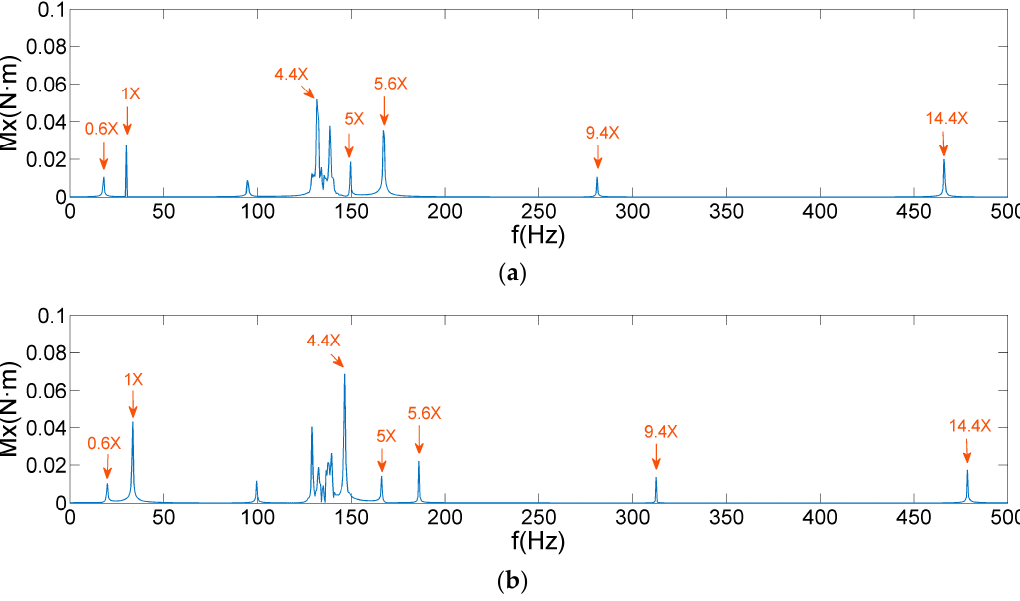
Figure 17. AIC–SVD denoised frequency spectra of M x : ( a ) 1800 rpm; ( b ) 2000 rpm. Table 3. Characteristic parameters of micro-vibration signals by AIC–SVD.